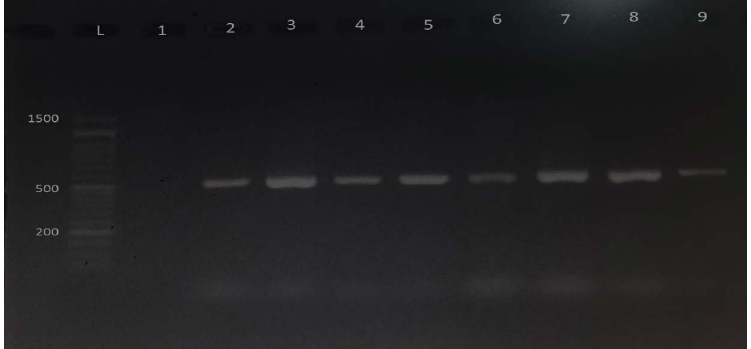
Fig. 3. Gel electrophoresis of PCR products of fim H gene visualized under U. V light after mixed with ethidium bromide. L: 1500 bp DNA marker; lane 2-9 positive for fim H gene and lane 1 negative result. The product size is 508 bp.